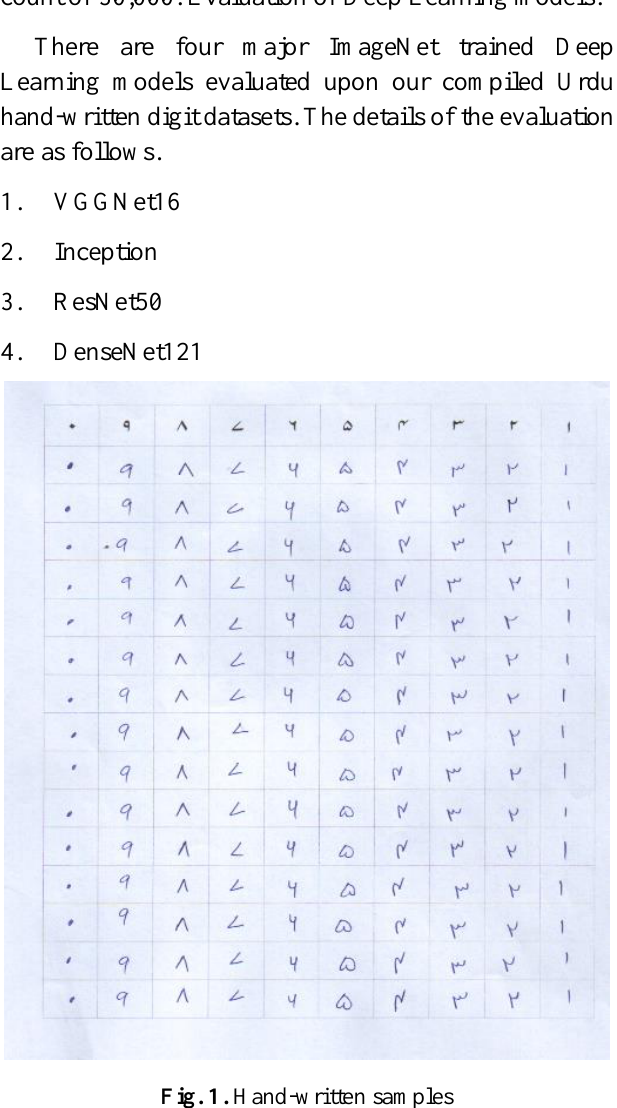
Fig. 1. Hand-written